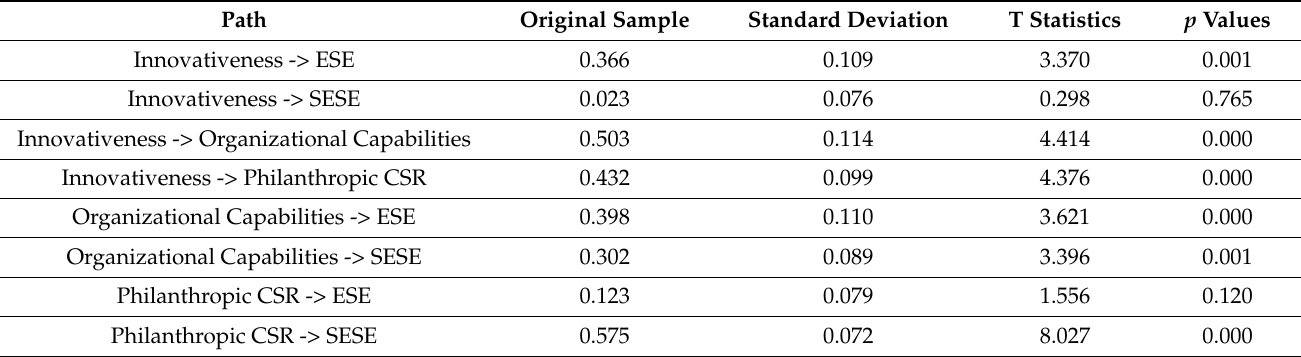
Table 2. Structural Model Assessment.